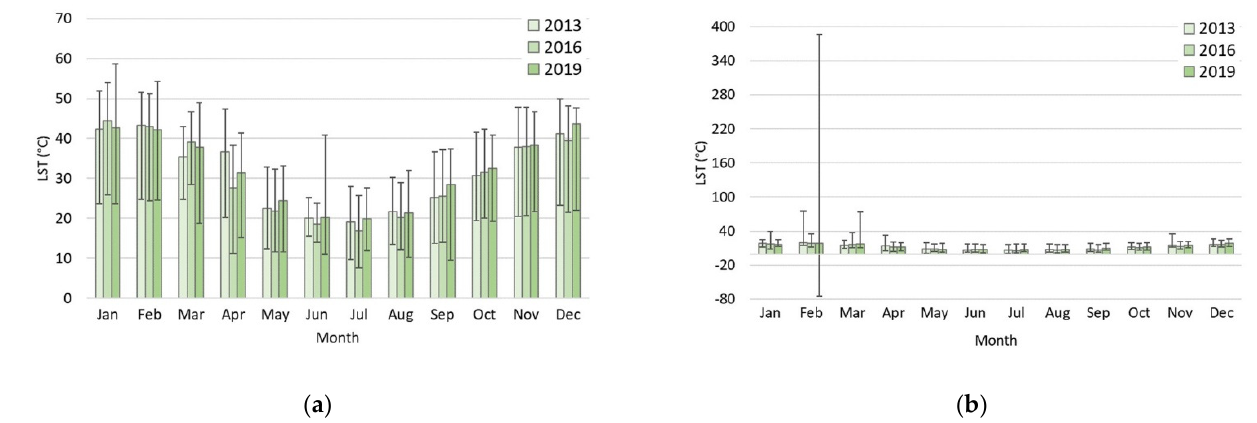
Figure 5. Perth MYD21A2 mean and min/max LST: ( a ) day and ( b ) night. The data for MYD11A2 show that values are well-distributed around the mean for day and night although some skewness into the higher temperatures is indicated at night (Figure 3b). The data for both VNP21A2 and MYD21A2 show more variability in the monthly high/low values than do the data for MYD11A2. VNP21A2 day recorded a low of − 0.69 °C in August 2013 (Figure 4a). MYD21A2 recorded a high of 386.6 °C and low of − 74.8 °C in February 2019. Some anomalous high values were also recorded in March and in February of 2013 (see Figure 5b and refer to Table S2).